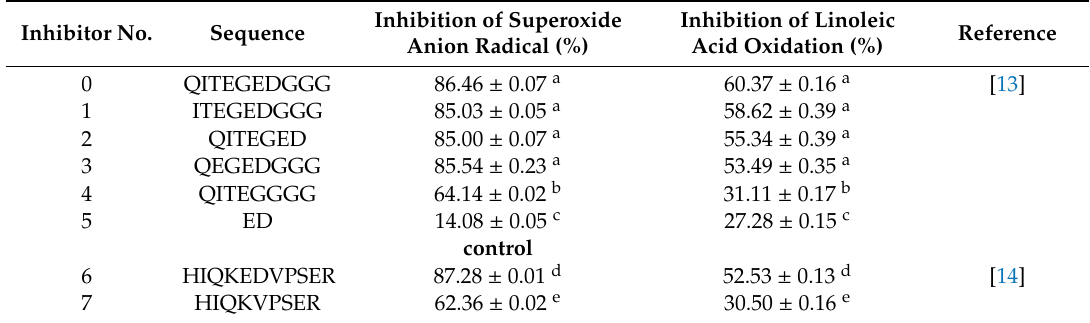
Table1. Theinhibitoryactivityofpeptideinhibitorsagainstsuperoxideanionradicalandlipidoxidation. Inhibitor